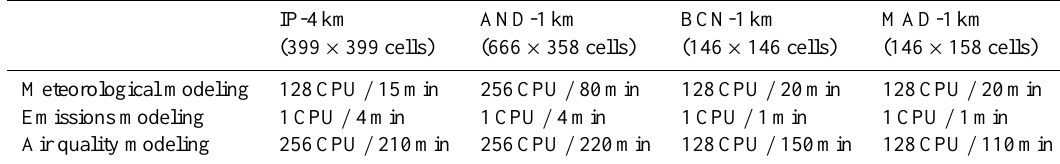
Table 1. CALIOPE-AQFS computational requirements, in terms of central processor units (CPUs) and computational time (inmin), for simulating 48h air quality forecasts as a function of the domains IP-4km (D2), AND-1km (D3), BCN-1km (D5) and MAD-1km (D4), all of which are described in Fig. 1. D domains are described in Fig.